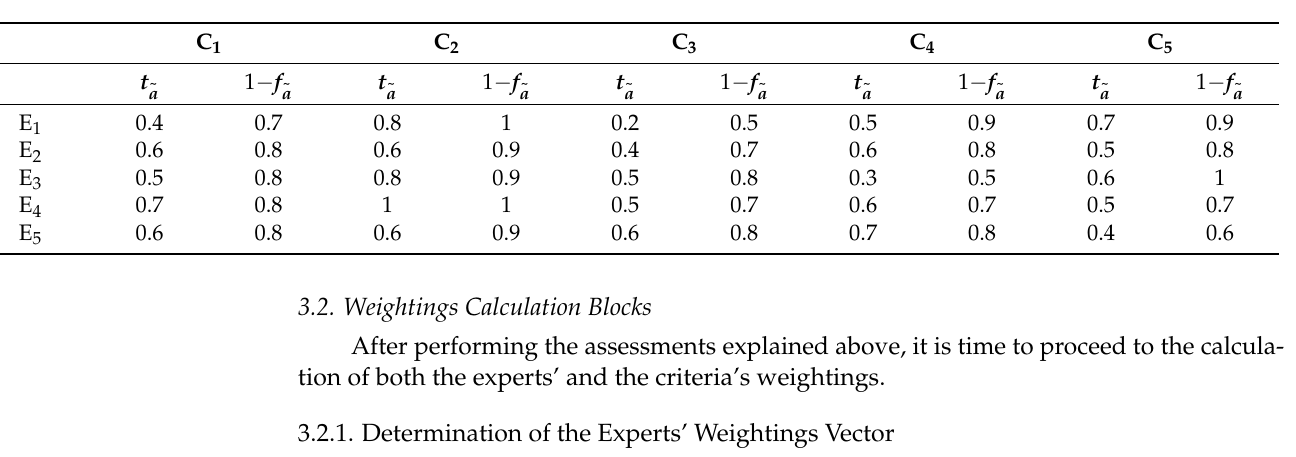
Table 7. Vague Fuzzy Decision Vectors of Criteria.